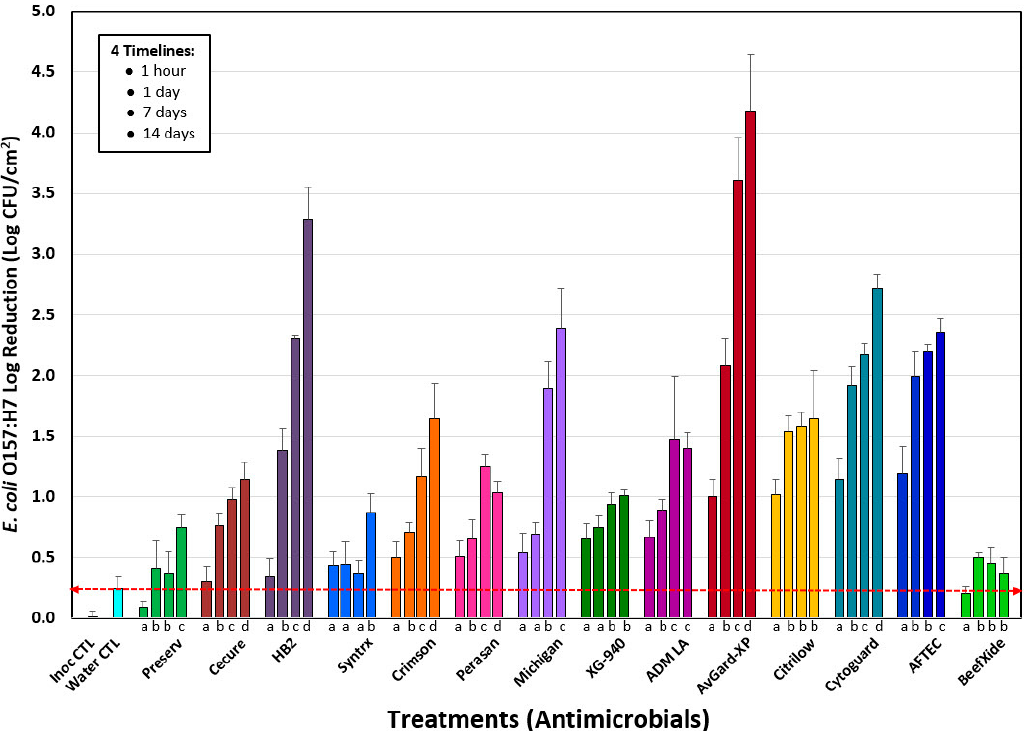
Figure 3. Reduction of E. coli O157:H7 on inoculated lean beef wafers passing through the tenderizer spray system. Data shows reductions observed relative to inoculated samples (Inoc CTL), water spray treatment (Water CTL), and 14 different antimicrobials. Groups of four data bars each represent samples processed within 1 h, 1-day, 7-days, and 14-days after treatment. Each antimicrobial data bar represents the mean of eight pairs of lean beef wafers ( n = 16) and error bars represent the standard deviation of the means. The “inoculation control (Inoc CTL)” and “water control (Water CTL)” data bars represent the difference from the mean of four pairs of lean beef wafers ( n = 8) conducted for each of the 14 antimicrobial trials ( n = 8 × 14 = 112 wafers) and the standard deviation represents the variance within the enumerated counts of these controls. A red dotted line indicates the mean of the reduction obtained by non-lethal water displacement of inoculum (Water CTL). One-way analysis of variance (ANOVA) was applied to data within each group of four time points for each antimicrobial. Data bars with the same lowercase letter (below the bars) are not significantly different; those with different letters are significantly different ( p < 0.05).